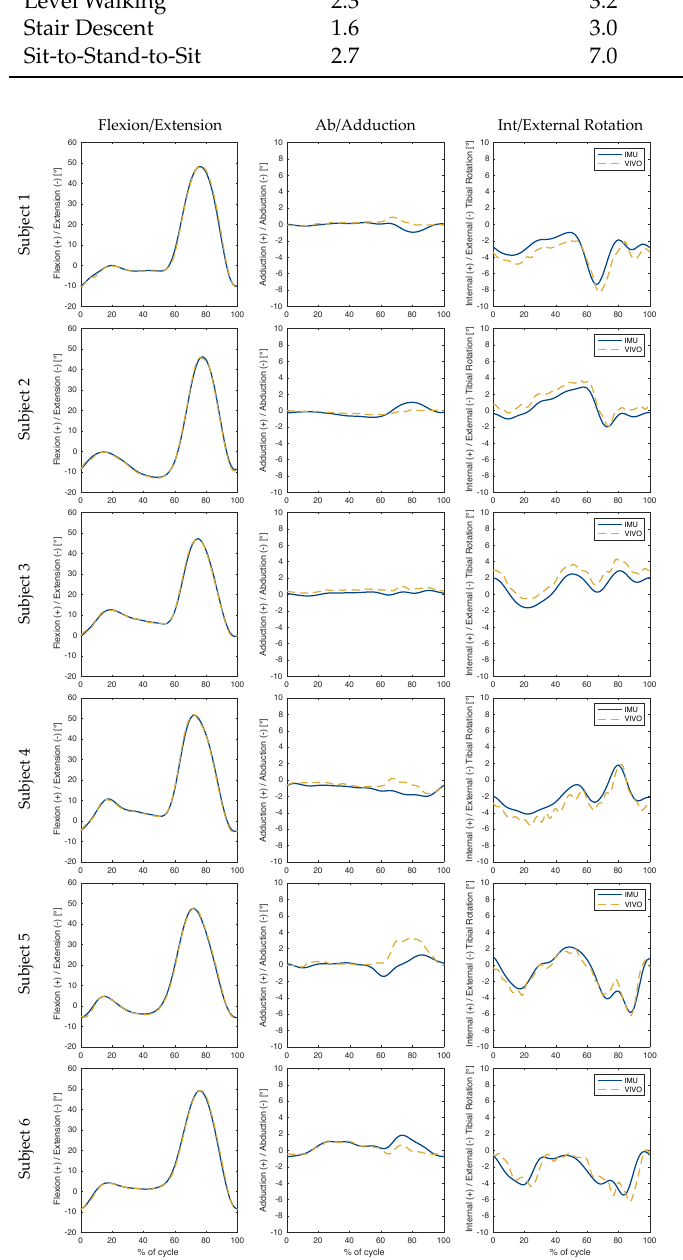
Figure 3. Level Walking: Knee joint angles were plotted over the progression (expressed as a percentage) of one complete gait cycle. The solid blue line illustrates the angles estimated using inertial data. The dashed gold line illustrates the ground truth angles performed by the joint simulator. Each row represents one subject, while each column presents rotations in a different plane relative to the femoral coordinate